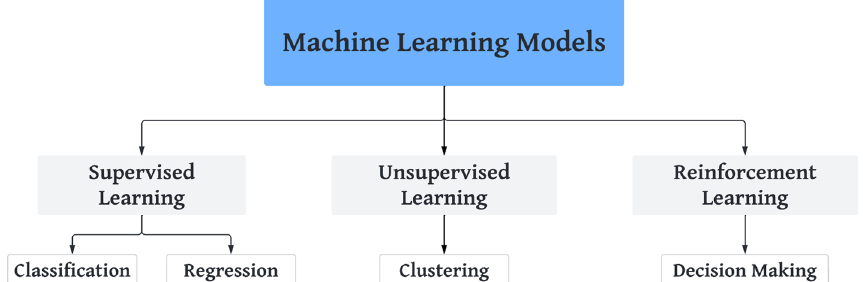
Fig.1 Machine Learning mod- els and main